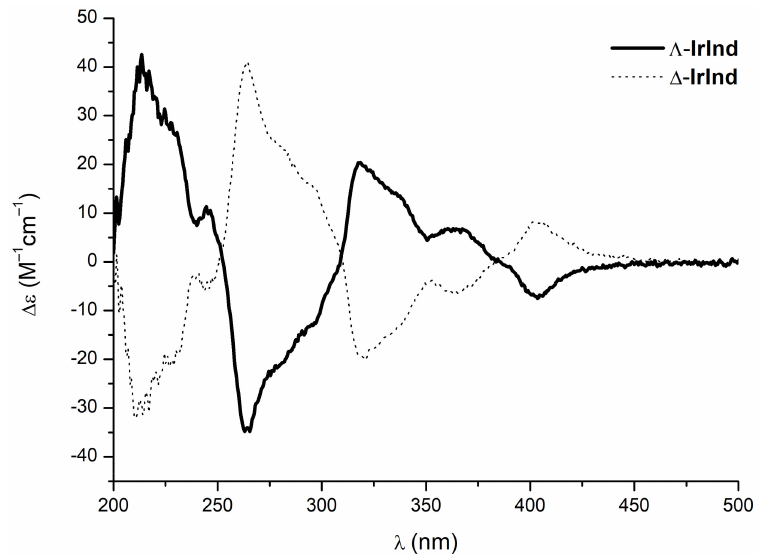
Figure 3. CD spectra of Λ - and ∆ - IrInd in MeOH (0.2